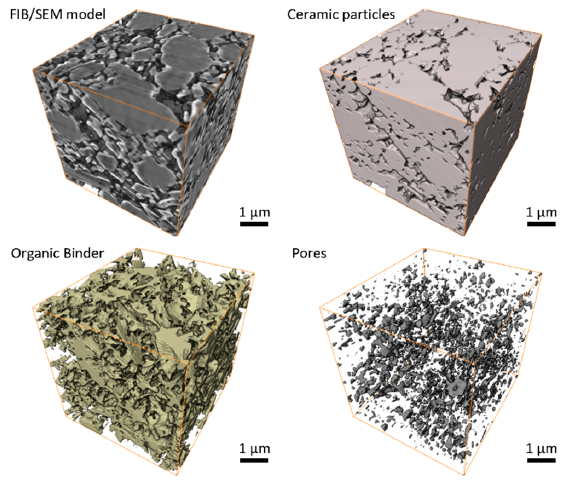
Figure 7. FIB/SEM-based 3D images of Al ₂ O ₃ greenbody ceramic sample, manufactured with stereolithography-based additive technology, there are shown the original FIB/SEM greyscale 3D image and the results of image segmentation: ceramic particles, an organic binder and pores.